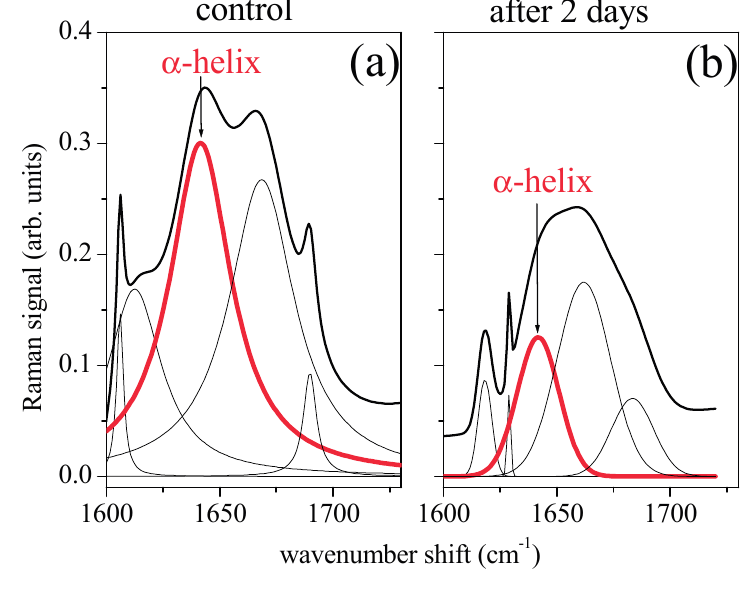
Figure 4. Amide I region of Raman spectrum of control PDLs ( a , c , e ) and after orthodontic treatment of 2 days ( b ), 7 days ( d ) and 14 days ( f ) respectively. Experimental data have been fitted by a convolution of Lorentzian or Gaussian functions. Raman mode assigned to α -helix is underlined by the red